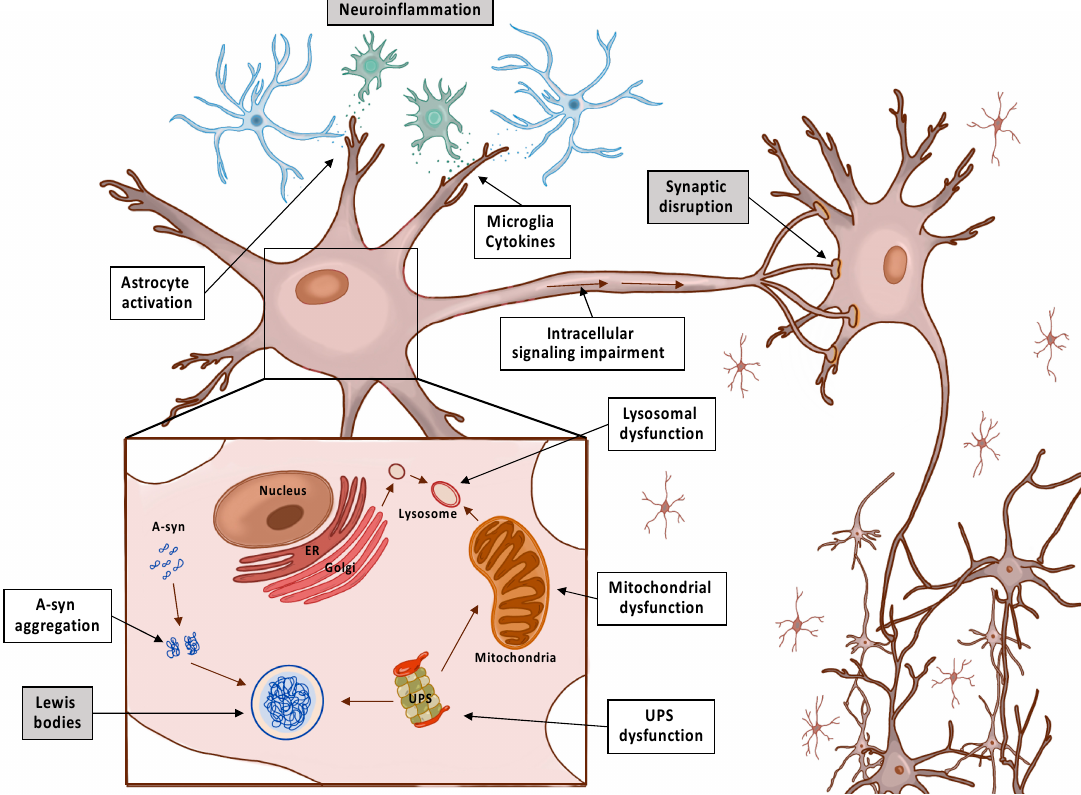
Figure 1. Schematic representation of the major hallmark events leading to Parkinson’s disease with the formation of Lewis bodies, ubiquitin proteosome system (UPS) dysfunction, neuroinflammation, and synaptic disruption with neurodegeneration. Endoplasmic reticulum (ER); alfa-synuclein (A-syn).